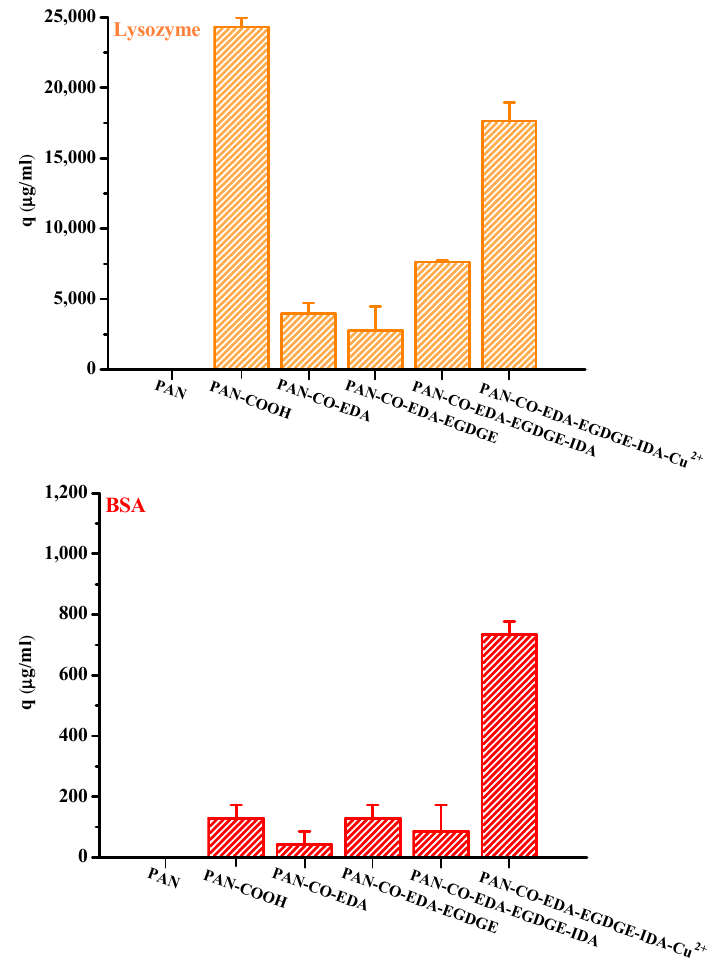
Figure 4. Protein adsorption results for the membranes obtained at each modification step in the process of IMAM preparation (under optimal reaction conditions) using the initial concentration of 0.5 mg/mL at room temperature for 24 h.